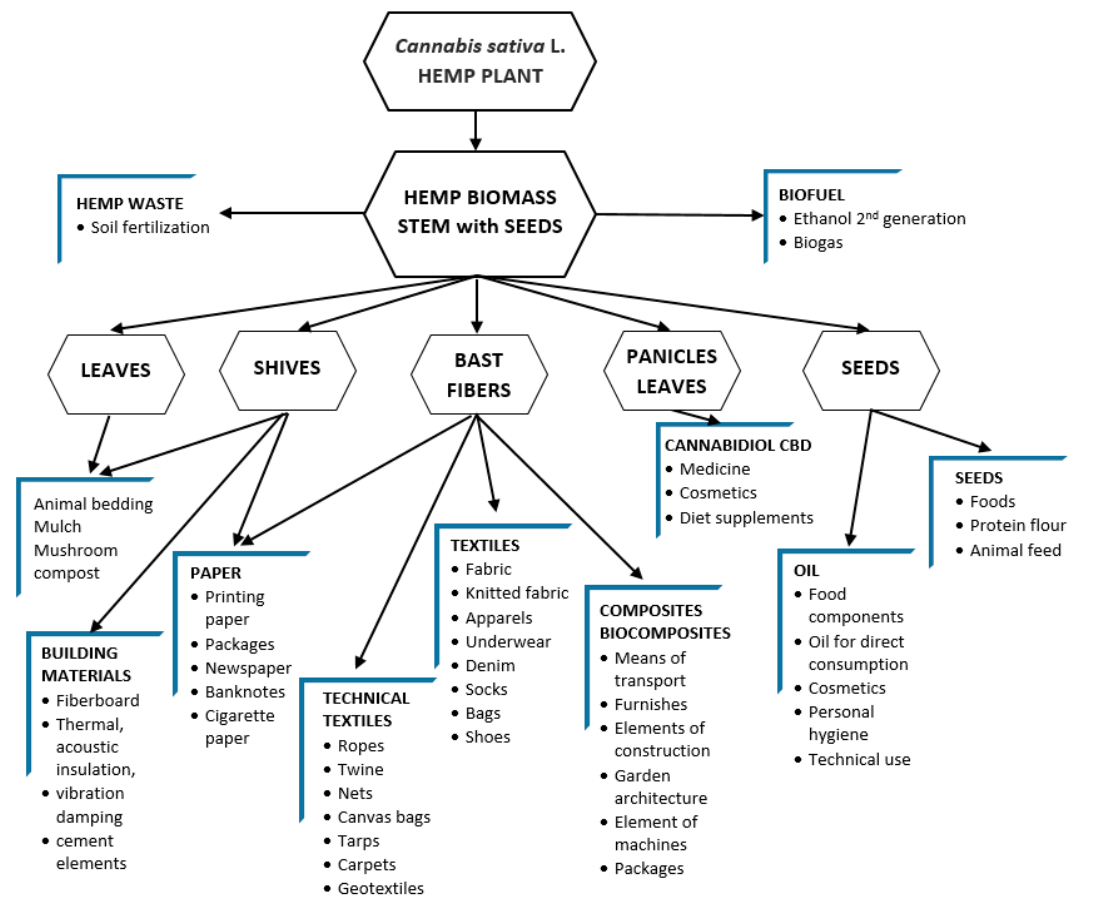
Figure 2. Schematic performance of multidirectional potential of the use hemp raw materials, based on [12].